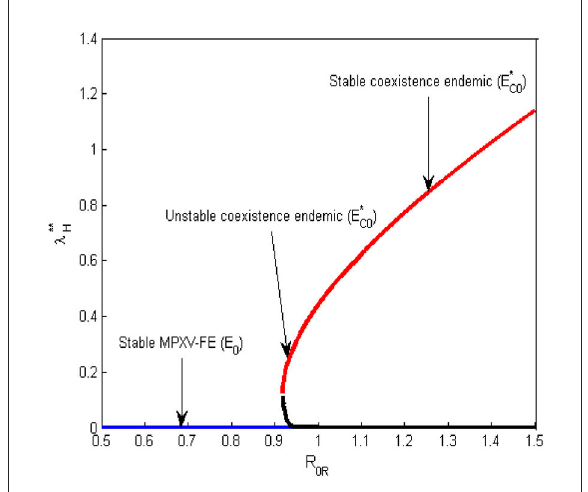
FIGURE3 Backward bifurcation plot for the transmission dynamics of the MPX infection at the rodent-rodent reproduction number ( R 0 R ) =